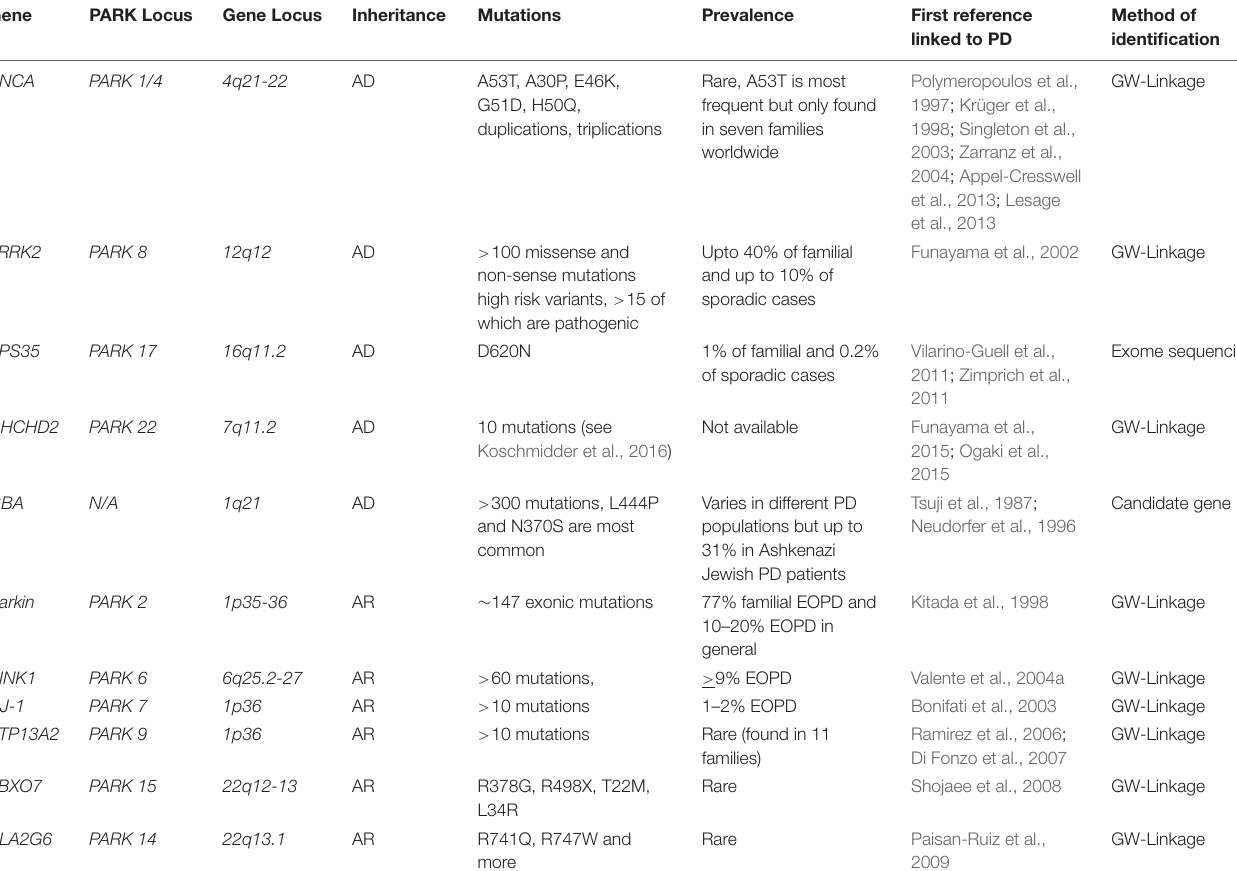
TABLE 1 | Major monogenic mutations and associated risk genes in